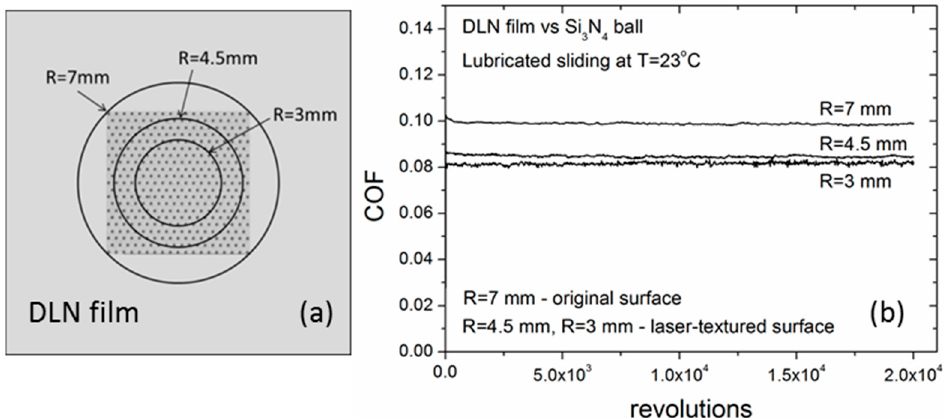
Figure 6. ( a ) Schematic of the friction measurements on the laser-textured DLN film, and ( b ) lubri- cated friction performance of the original film ( R = 7 mm) and laser-textured ( R = 4.5 mm and R = 3mm) surface at T = 23 °C; load 1 N, sliding speed 5